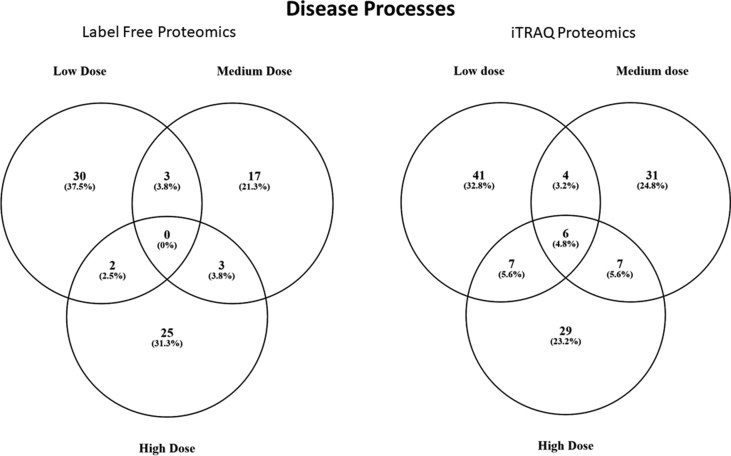
Comparison of disease networks affected in all three doses, using label free proteomics (left graph) and iTRAQ proteomics (right graph).